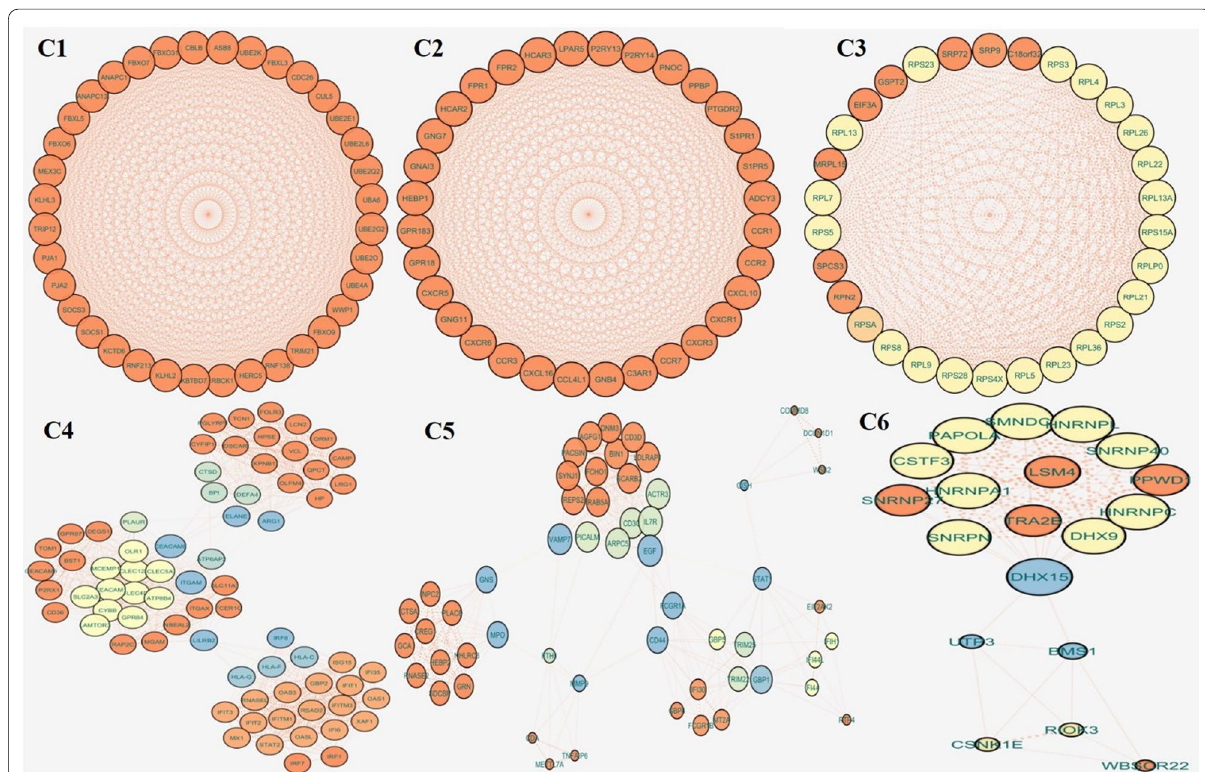
Fig. 7 Gene clusters as viewed in Cytoscape. For each distribution of genes belonging to each cluster accordingly as C1–C6. The different colours in each network represent the BC value (low values to bright colour and high values to dark